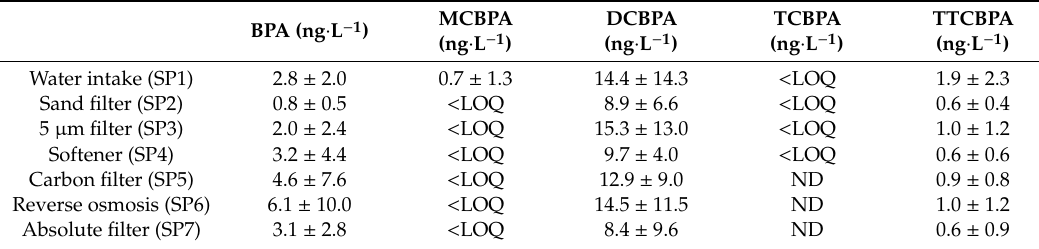
Table 3. Concentrations of bisphenol A and its chlorinated derivatives measured at the inlet and after each treatment step of the water treatment process. Mean ± standard deviation are presented are presented (LOQ = limit of quantification and ND = non